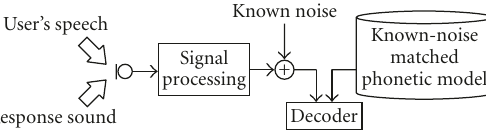
Figure 17: Configuration of known-noise